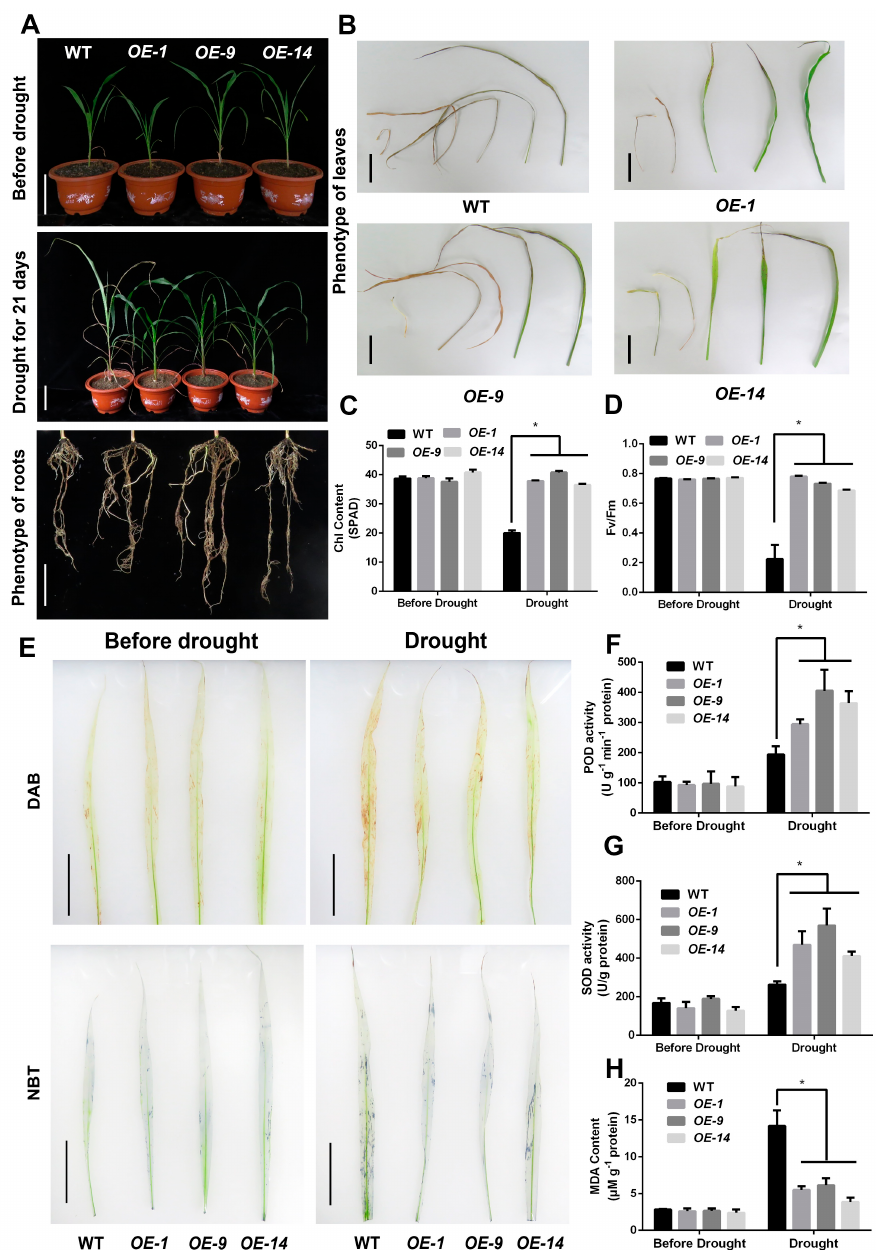
Figure 3. Overexpression of SbNAC9 enhanced drought-stress tolerance of sorghum. ( A ) Phenotype of sorghum plants under drought-stress treatment. Three-week-old WT and transgenic lines ( OE-1 , OE-9 , OE-14 ) were treated with water deprivation for 21 days. Bars indicate 10 cm. ( B ) Phenotype of first five leaves of WT and transgenic lines after 21-day drought-stress treatment. Bars indicate 5 cm. ( C , D ) Chlorophyll content ( C ) and chlorophyll fluorescence Fv/Fm ( D ) in the fifth leaf of WT and transgenic lines after drought treatment. Error bars indicate SD of three independent experiments. * p < 0.05 by Student’s t- test. ( E ) DAB and NBT staining of leaves of WT and transgenic sorghum seedlings treated with drought stress for 5 days. Bars indicate 5 cm. ( F – H ) POD activity ( F ), SOD activity ( G ), and MDA content ( H ) of WT and transgenic lines after drought-stress treatment. Error bars indicate SD of three independent experiments. * p < 0.05 by Student’s t ‐ test.